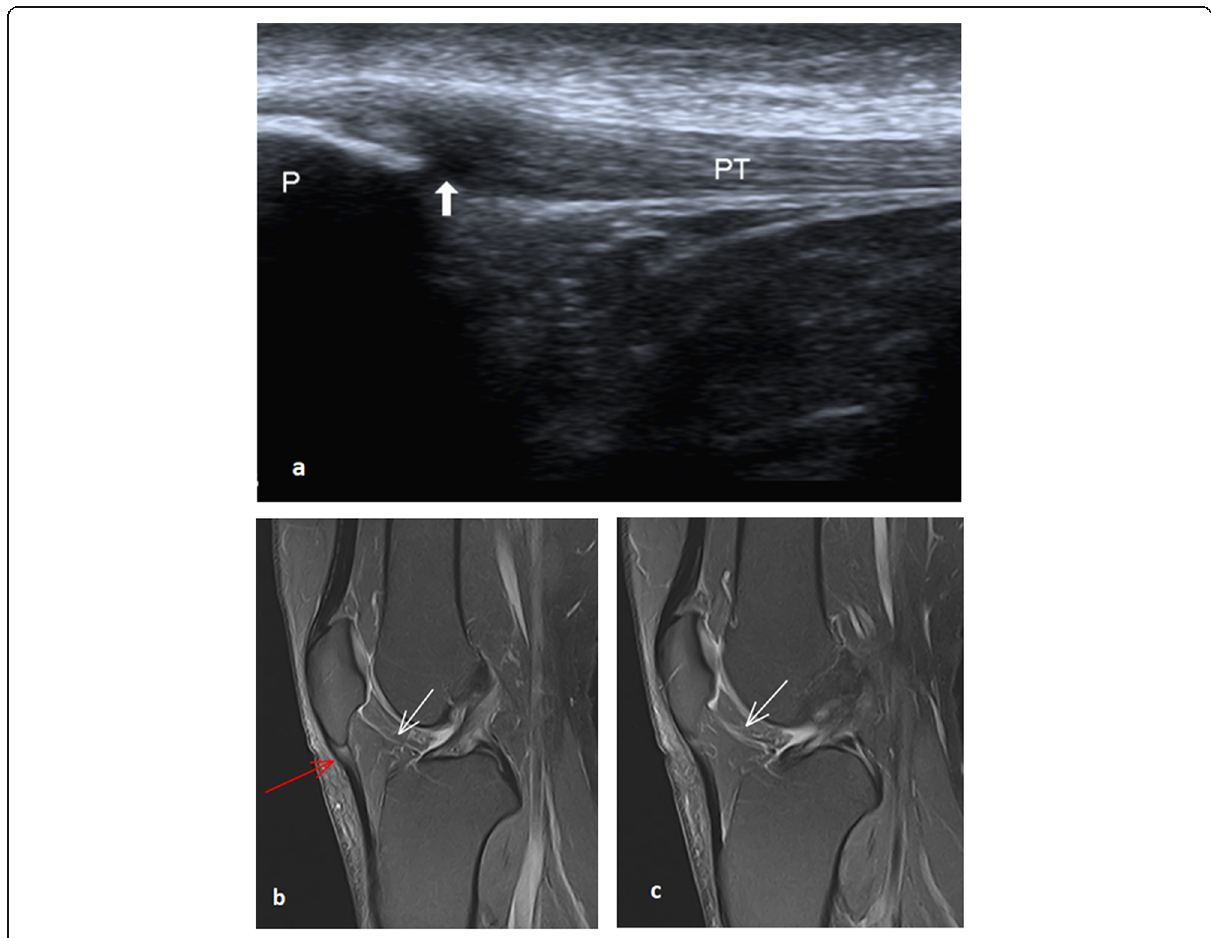
Fig. 8 A 45-year-old female with right patellar tendinopathy and infrapatellar plica. a Long axis ultrasound image through the patellar tendon shows a focal thickening of the proximal part of the patellar tendon with a localized hypoechoic area sparing the anterior fibers. (White thick arrow). b and c Two subsequent sagittal PDFS MRI images through intercondylar notch show focal proximal tendon thickening and increased signal intensity (red arrow) sparing the anterior tendon fibers. Infrapatellar plica (white arrow) appears as a curvilinear high signal passing through Hoffa ’ s fat pad (not detected by ultrasound). P, patella; PT, patellar